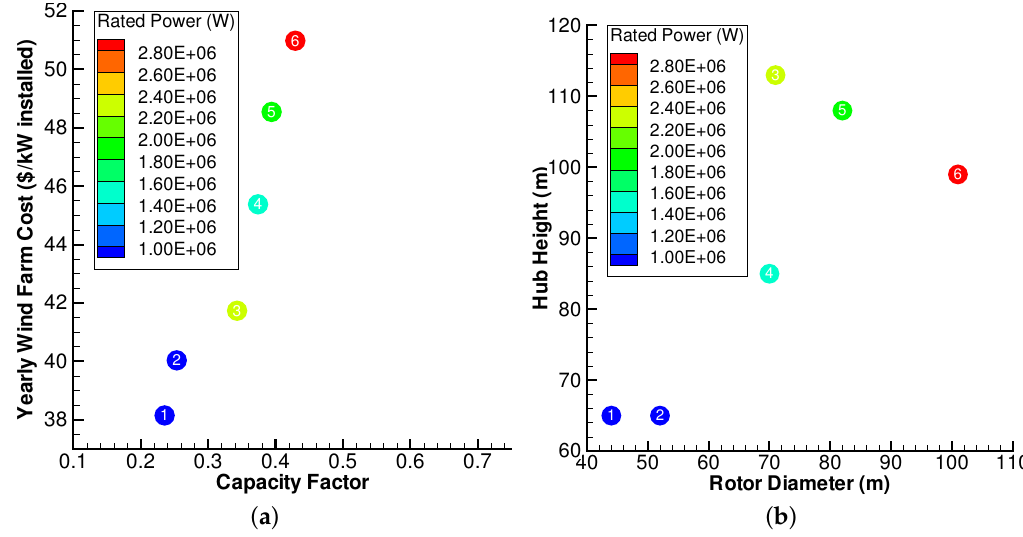
Figure 14. Tradeoffs offered by the best performing turbines of different rated powers for Case I: Class 1–2 winds. ( a ) Best tradeoffs between the capacity factor and average annual cost ($/kW installed); ( b ) rotor diameters and hub heights of the best tradeoff turbines.